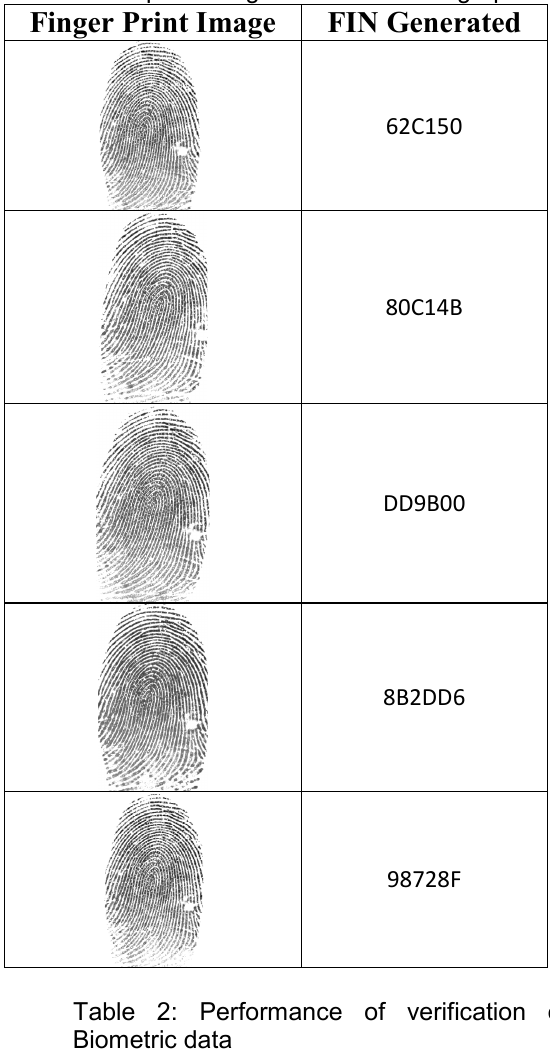
Table 1: Sample FINs generated from Fingerprints